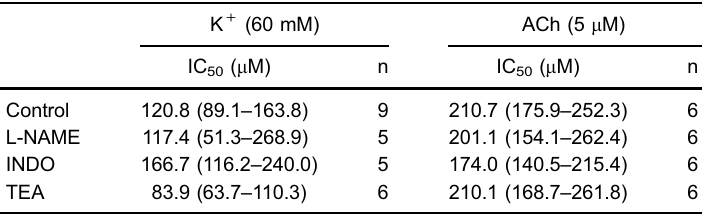
Table 1. IC 50 values for the relaxing effects of b -citronellol on sustained contractions induced by K + or ACh in rat tracheal rings.